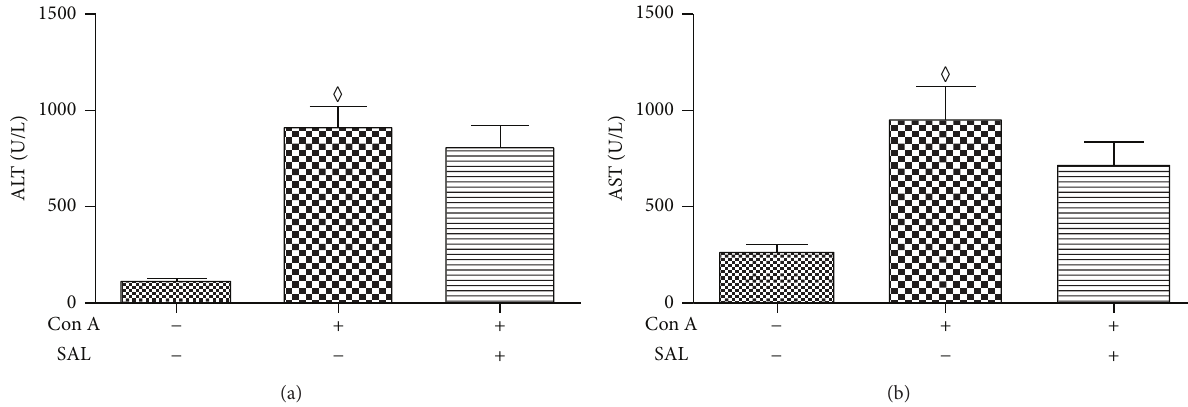
Figure 8: Salidroside cannot attenuate liver damage following Con A administration. (a) and (b) demonstrated that ALT and AST levels did not show any difference between Con A and salidroside groups ( 𝑛 = 10 mice per group); ◊ 𝑃 > 0.05 versus salidroside